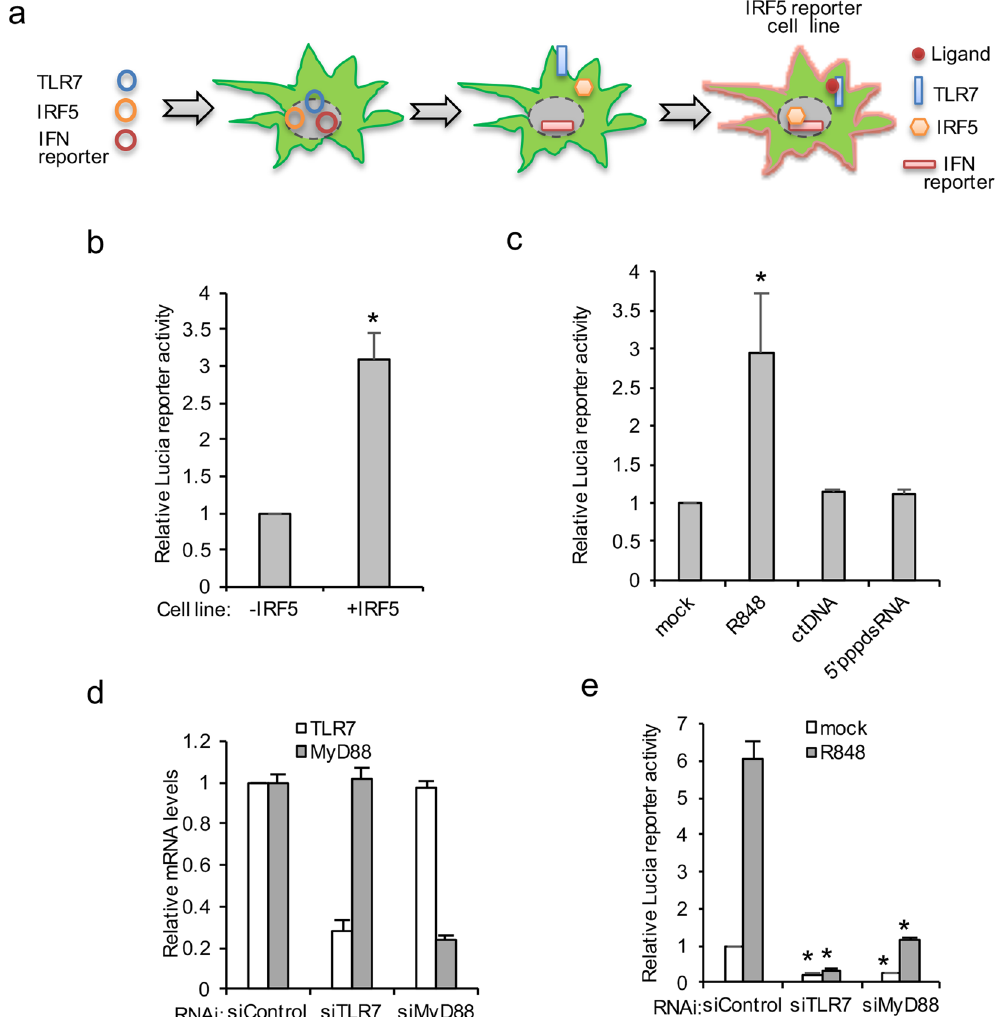
Figure 3. Characterization of IRF5 reporter cell line. ( a ) Illustration of procedures for generation of IRF5 reporter cell line. ( b ) HEK293/TLR7/Lucia cells expressing vector or IRF5 were stimulated with 10 μ g/ml R848. After 16 hr, luciferase activity was measured. All experiments were repeated three times and two-tailed student t -test was performed. An asterisk indicates p < 0.05. ( c ) The IRF5 reporter cells were treated with 10 μ g/ml R848, 1 μ g/ml ctDNA or 1 μ g/ml 5 ′ -ppp-dsRNA. After 16 hr, luciferase activity was determined. ( d ) The IRF5 reporter cells were transfected with control siRNA, siTLR7 or siMyD88. After 72 hr, cells were treated with 10 μ g/ml R848 for 16 hr. Cells were then collected and RNA was extracted. RT-PCR was performed to determine the relative levels of TLR7 and MyD88 mRNA expression which were normalized using the GAPDH housekeeping gene. ( e ) The IRF5 reporter cells were transfected with control siRNA or siRNA against TLR7 (siTLR7) or MyD88 (siMyD88). After 72 hr, cells were treated with 10 μ g/ml R848 for 16 hr. Luciferase activity and CellTiter- Glo were measured. The ratio of luciferase to CellTiter-Glo was calculated. Relative activity was normalized by the control. All experiments were repeated three times and two-tailed student t -test was performed. An asterisk indicates p <